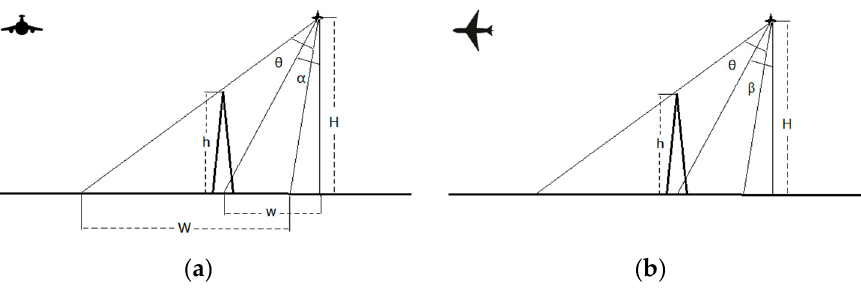
Figure 2. Imaging geometry for UAV-based oblique photogrammetry: ( a ) imaging geometry for roll angle; and ( b ) imaging geometry for pitch angle.